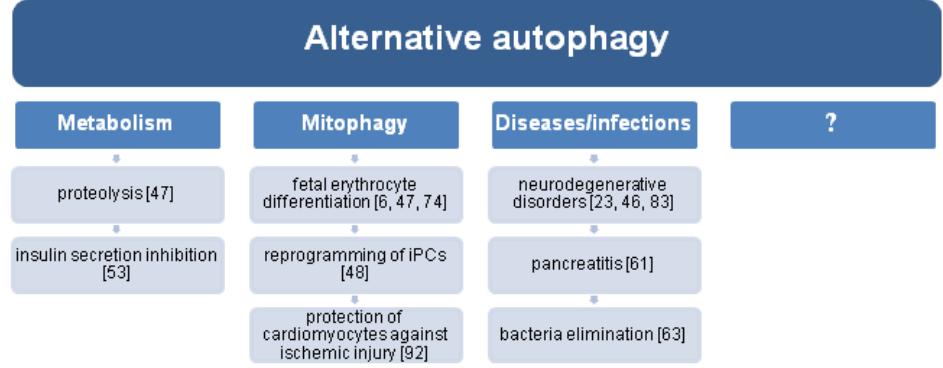
Figure 2. The roles of alternative autophagy. Graphical elements were adapted from Servier Medical Art (smart.servier.com).